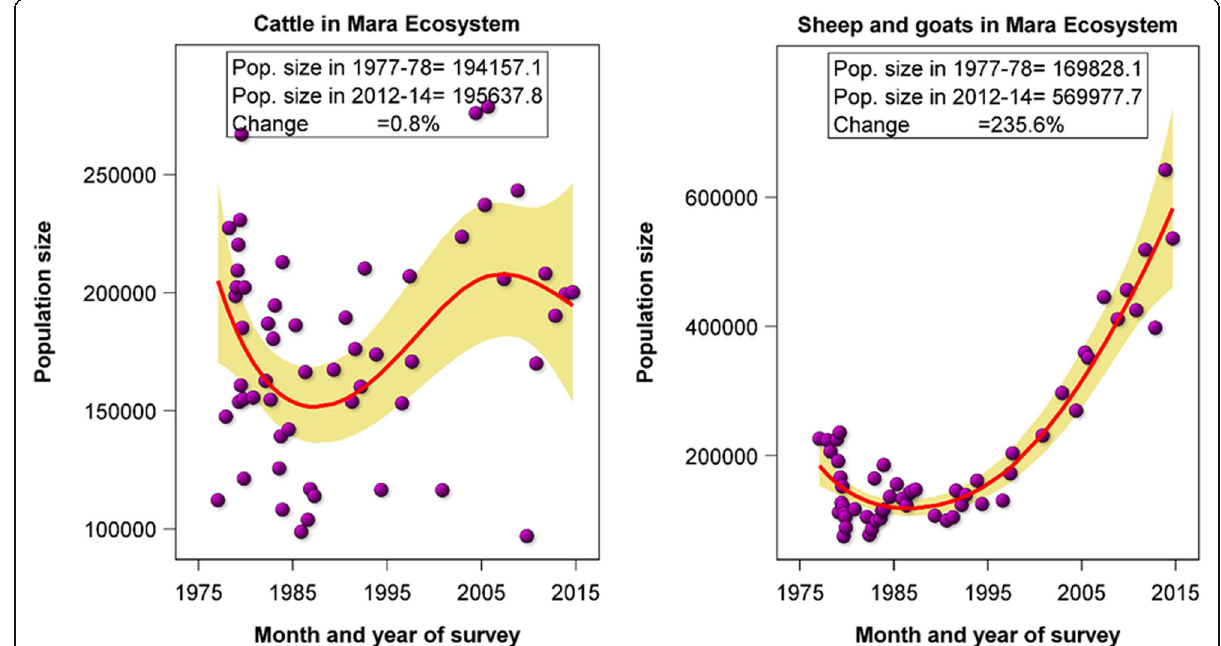
Figure 7 Trends in cattle and shoat populations in the Mara ecosystem from 1977 to